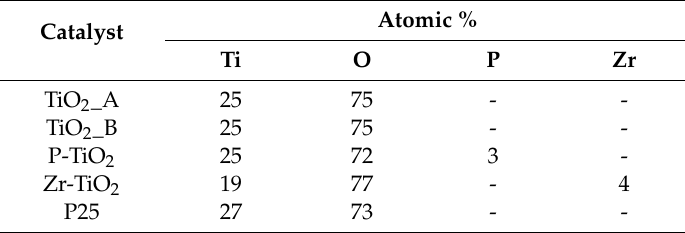
Table 4. Atomic percentage of the elements on the catalyst surfaces.